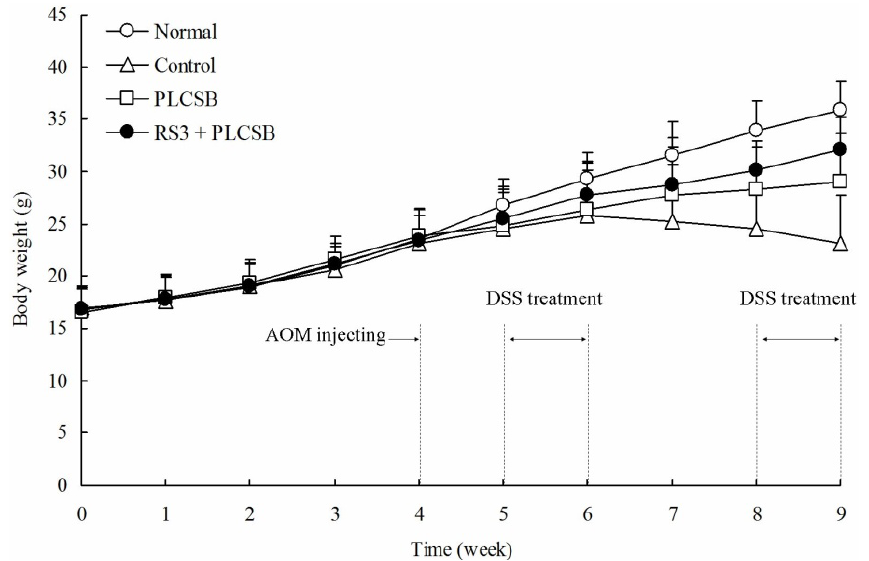
Figure 1. Changes in the body weight of AOM and DSS-induced colon cancer mice during the